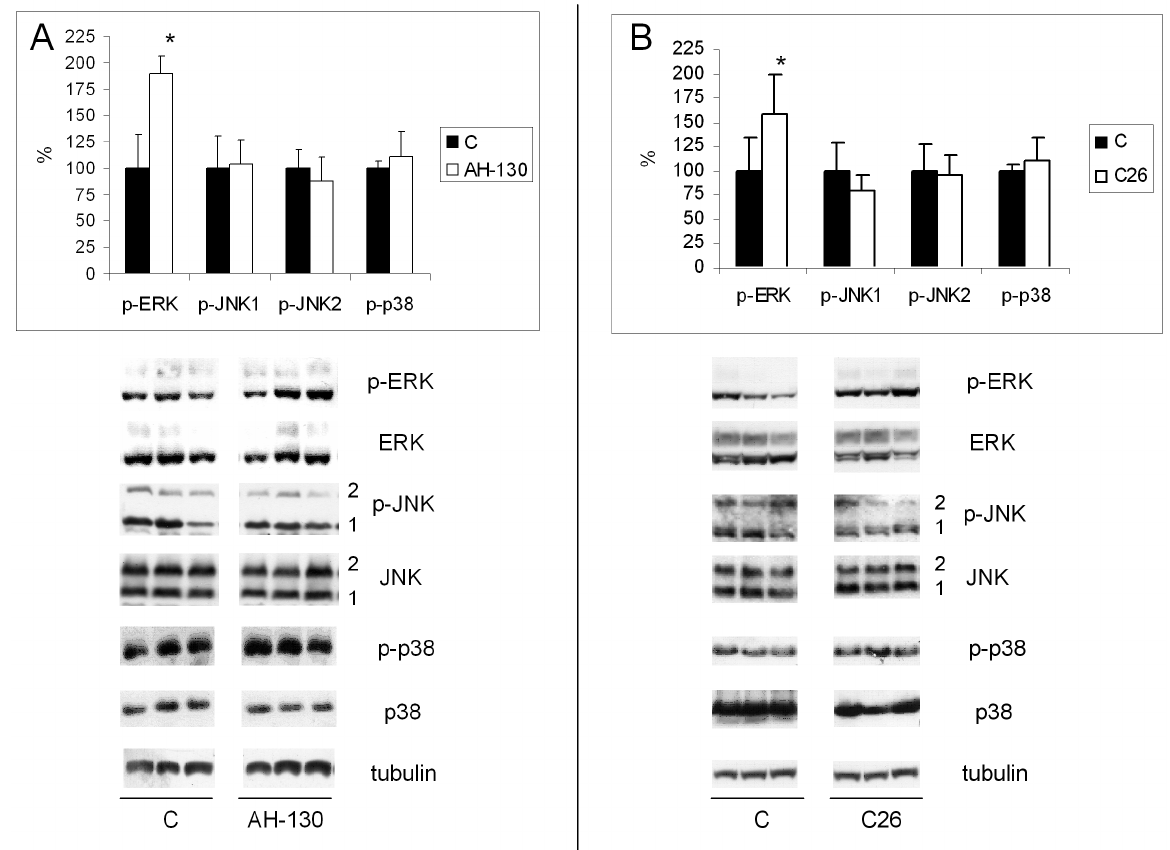
Figure 1. ERK is activated in the skeletal muscle of TB animals. Levels of phosphorylated MAPKs in the GSN. Panel A : control (C; n=6) and AH- 130-bearing rats (n=8). Panel B : control (C, n=8) and C26-bearing mice (n=8). Levels of phosphorylation were normalized by total protein content. Data (means 6 SD) expressed as percentages of controls. Significance of the differences: *p , 0.05 vs C.